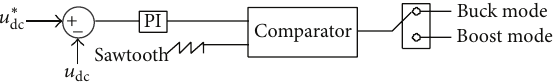
capacitance and resistance in series. The energy storage system connects to the sub-microgrid DC bus through the bidirectional buck-boost